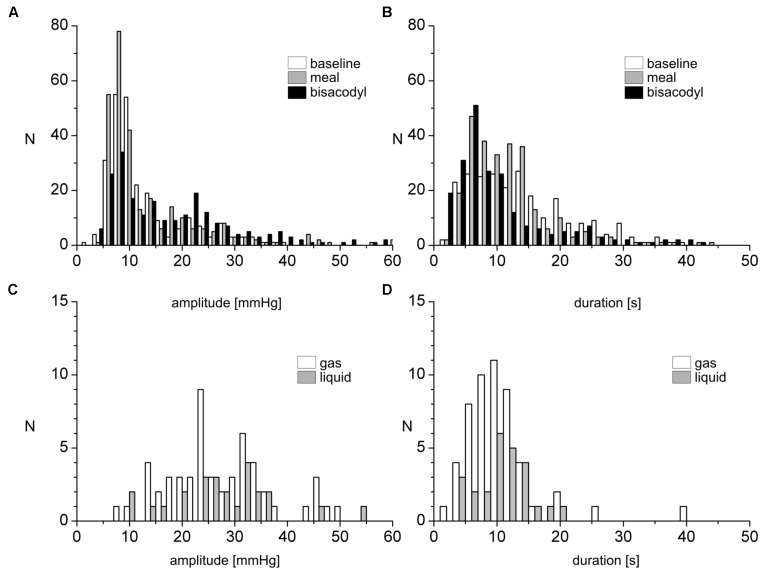
Amplitude and duration distribution of SPWs and their relationship to gas or liquid expulsion. (A,B) Number of occurrences of SPWs, binned according to amplitudes (A) or duration (B), observed in 17 subjects, before and after a meal and in response to bisacodyl. (C,D) Number of occurrences of SPW amplitudes (C) and durations (D) for SPWs associated with gas or liquid expulsion under all conditions.